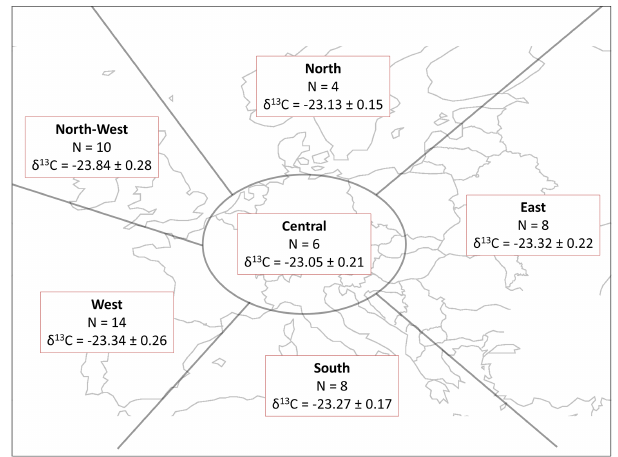
Figure 6. Isotopic signatures for different source regions, includ- ing corresponding sample number as well as the average δ 13 C. The source regions for the sampled aerosol were designated based on the main wind direction (see